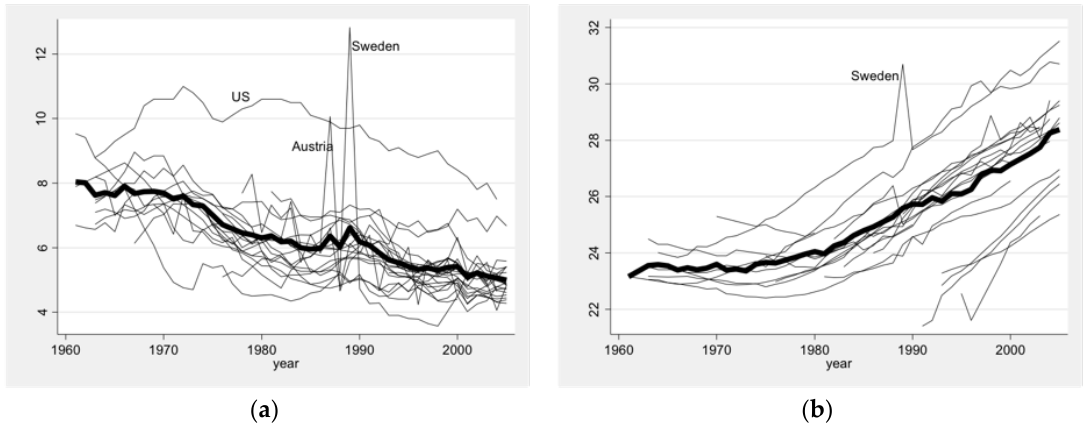
Figure 1. Trends in Marriage Rates and Average Age at First Marriage, 1961–2005. ( a ) Marriage Rates; ( b ) Marriage Age.